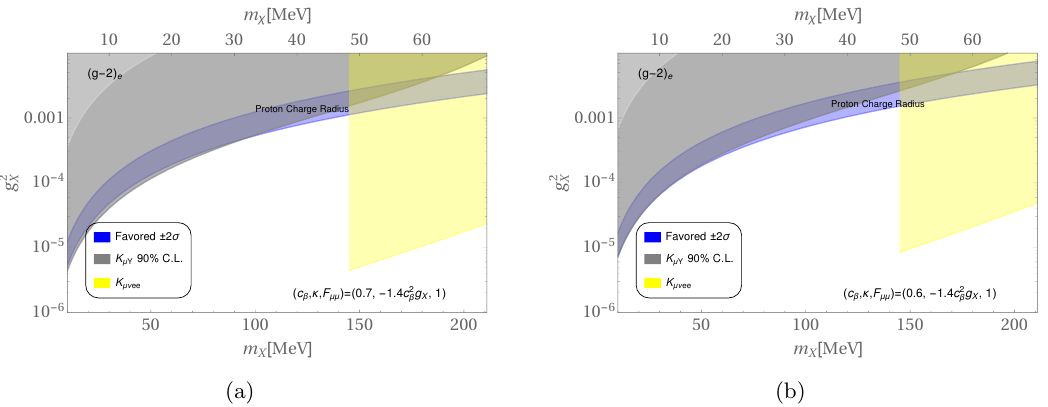
Figure 4 . The allowed region for m X and g 2 are presented, when the ( g (cid:0) 2) e curve is minimazed X by requiring the cancellation of the vector and axial contributions, as described in the text. Two values of c 2 are used. The blue region is allowed by proton anomaly. (cid:12)